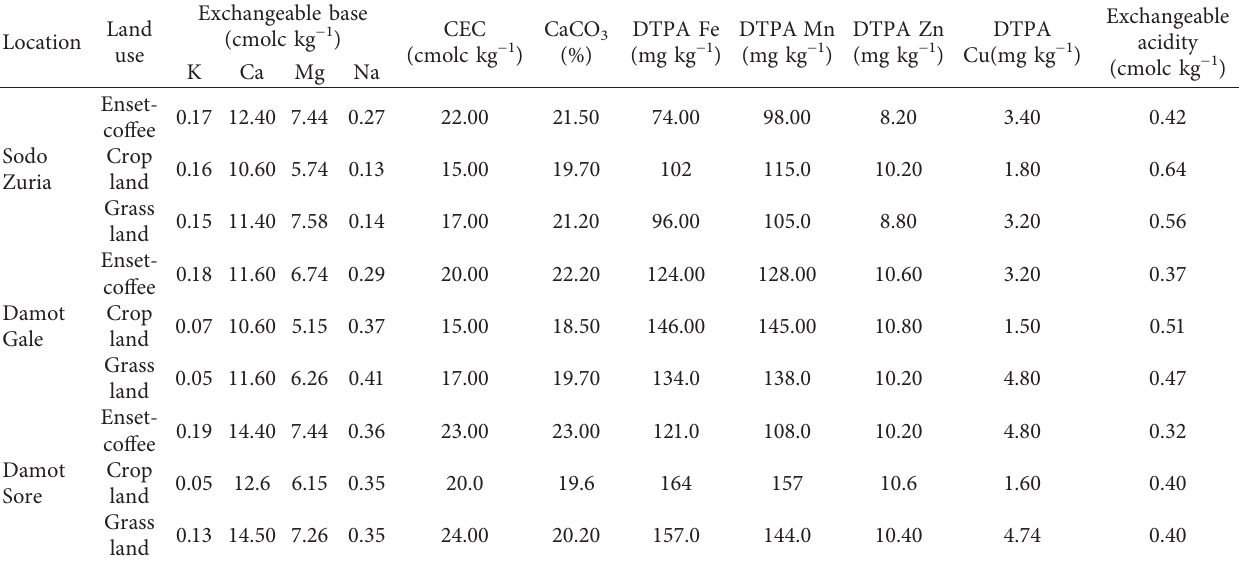
Table 2: Selected physical and chemical properties of the soils as influenced by land uses and locations.